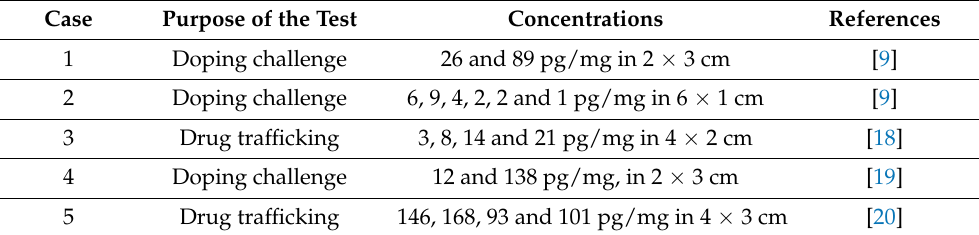
Table 4. Ostarine concentrations in human hair reported in the